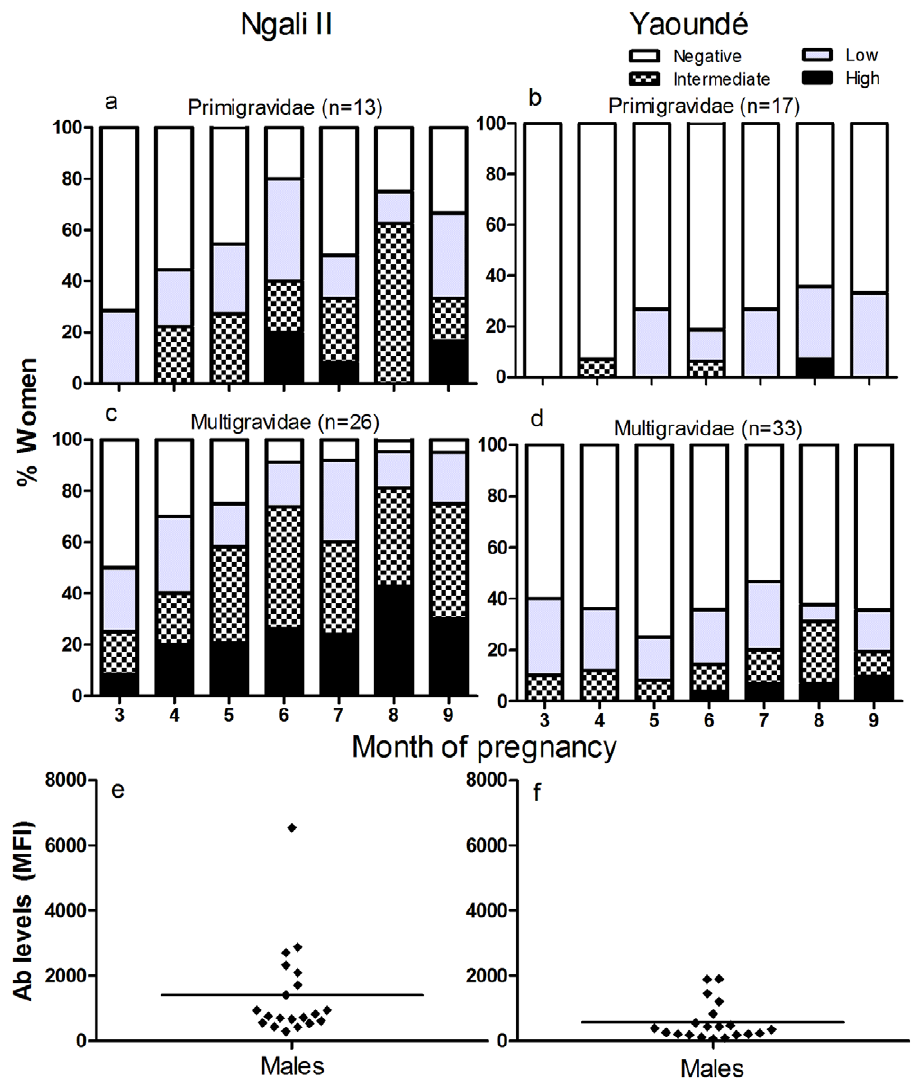
Figure 1. Natural Acquisition of IgG Antibodies to VAR2CSA. ( a–d ) Ab levels to FV2 were determined using plasma from ( a, b ) primigravidae and ( c, d ) multigravidae in Ngali II and Yaounde´. The total number of samples evaluated per month ranged from 19–37 for Ngali II and 39–46 for Yaounde´. Ab levels were divided into 4 categories: negative (white; below cutoff: the mean + 2 SD of adult males in the same site), low (grey; above cutoff, but , 5000 MFI), intermediate (checkered; 5,000–10,000 MFI) and high (black; . 10,000 MFI). The percentage of women within each Ab group is shown. Women with Ab levels $ 5,000 MFI were considered to have strong Ab responses. ( e–f ) In comparison to pregnant women, only 1/40 male who lived in the two study sites had intermediate and 6/40 had low Ab levels to FV2. Antibody cutoff values for Ngali II and Yaounde´ women were 2756 and 1192 MFI, respectively.